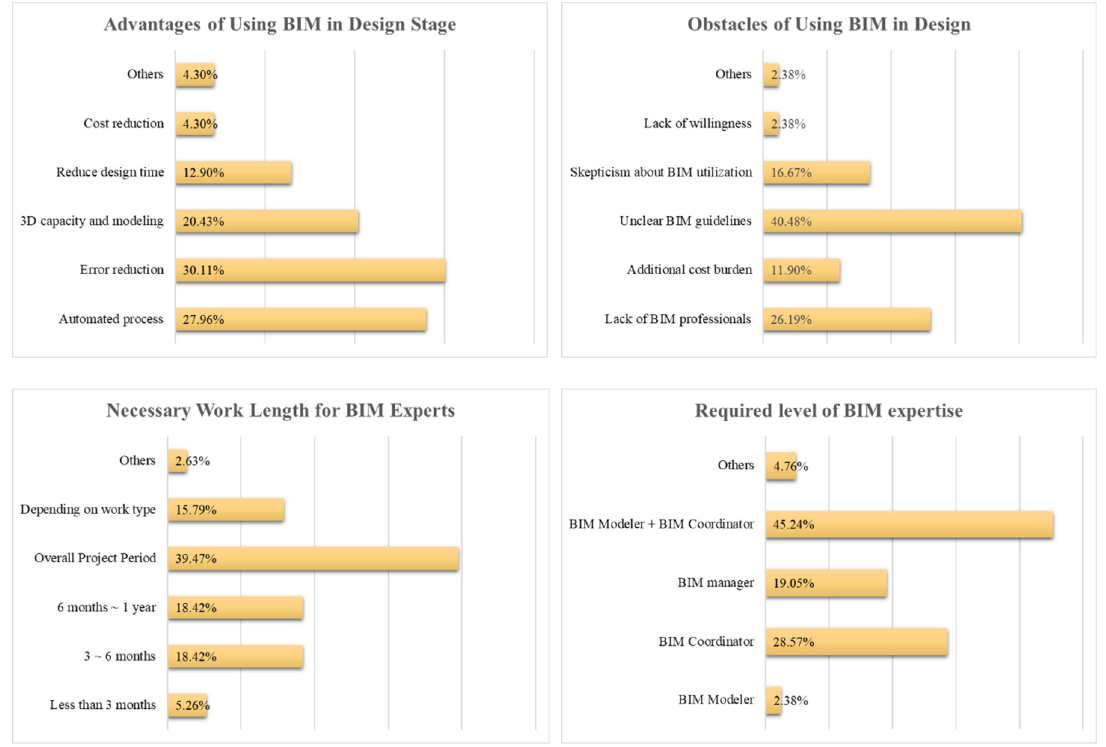
Figure 4. Preferences on BIM during Design Stage.